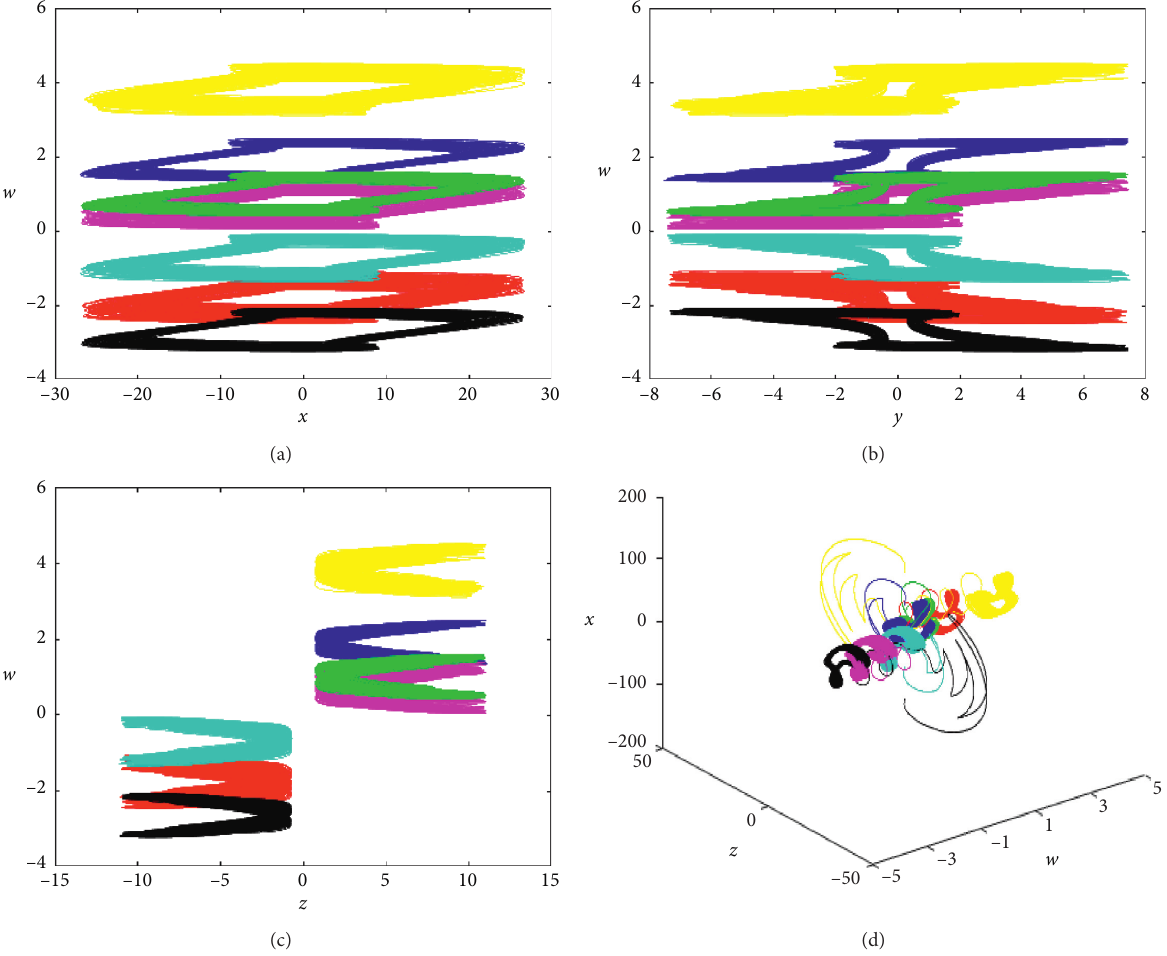
Figure 9: Phase portraits of coexisting infinitely many attractors on (a) x − w plane, (b) y − w plane, (c) z − w plane, and (d) w − z − x plane in chaotic system (2) (the blue one starts from initial conditions ( 10 , 1 , 0 , 0 ) , the red one starts from (− 10 , 1 , 0 , 0 ) , the pink one starts from ( 50 , 1 , 0 , 0 ) , the cyan one starts from (− 50 , 1 , 0 , 0 ) , the yellow one starts from ( 100 , 1 , 0 , 0 ) , the black one starts from (− 100 , 1 , 0 , 0 ) , and the green one starts from ( 1 , 1 , 0 , 0 )